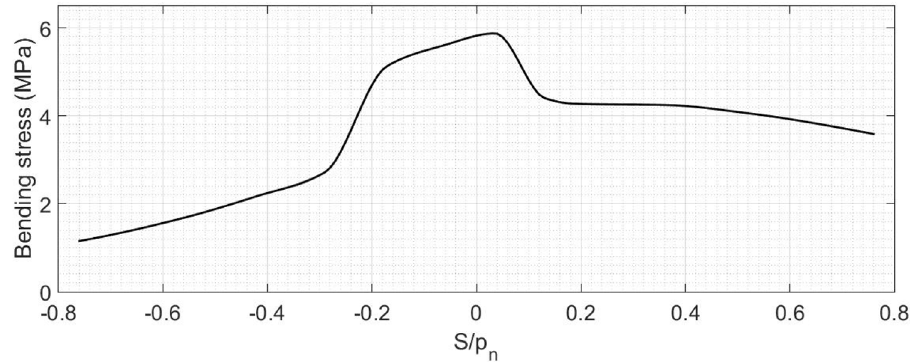
Fig. 17. Variation of the bending stress at the tooth fi llet for the 40/40 gear pair under low torque.